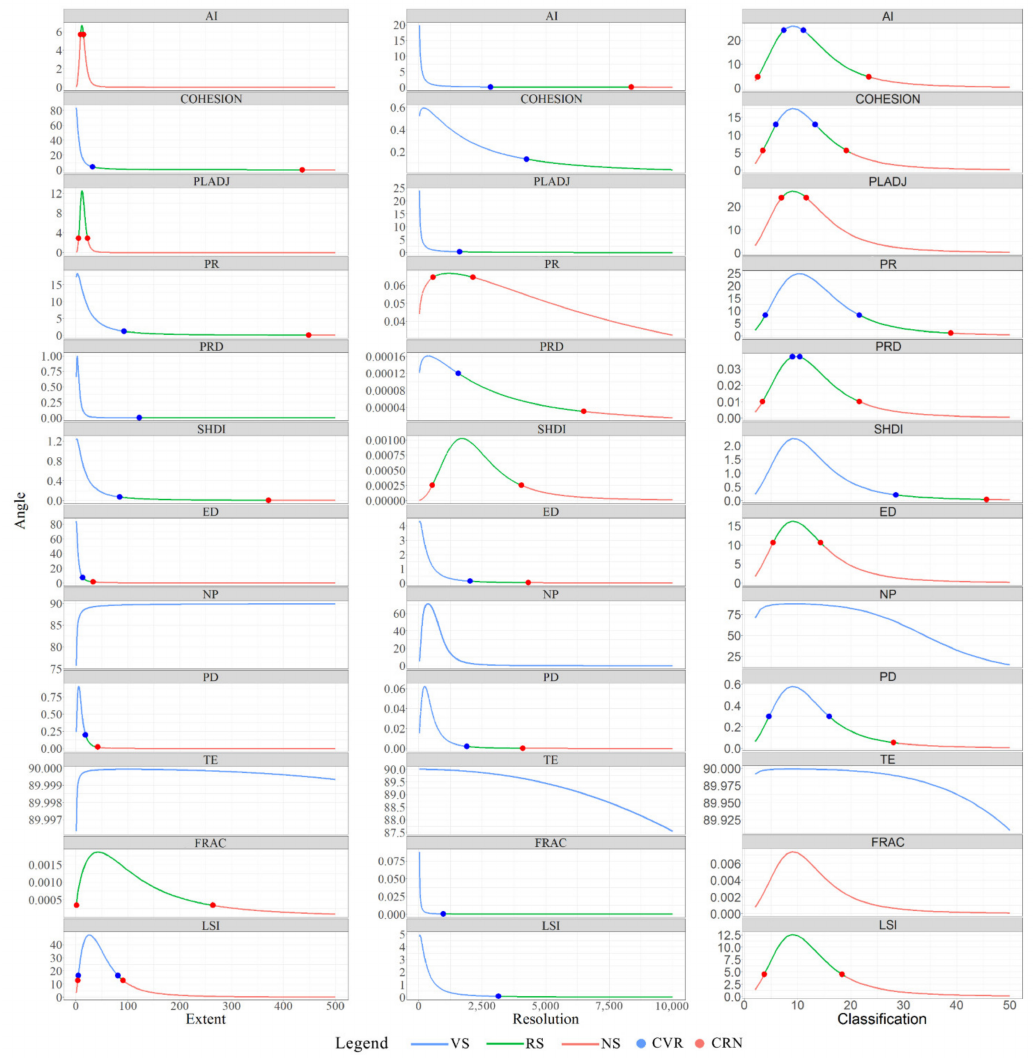
Figure 7. The landscape metrics’ scaling sensitive scalograms, their critical points and predicted thresholds. VS means highly sensitive segments, NS means insensitive segments, RS means sensitive transition segments, CVR means the critical points between highly sensitive and sensitive transition segments, CRN means the critical points between insensitive and sensitive transition